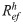
Estimation of Model SIR in Period 2 (October/2000—September/2004).(a) observed incidence (O) and adjusted i (E), (b) m3/m, (c) Refh (h) and Refm (m), and (d) Ref=Refh×Refm.